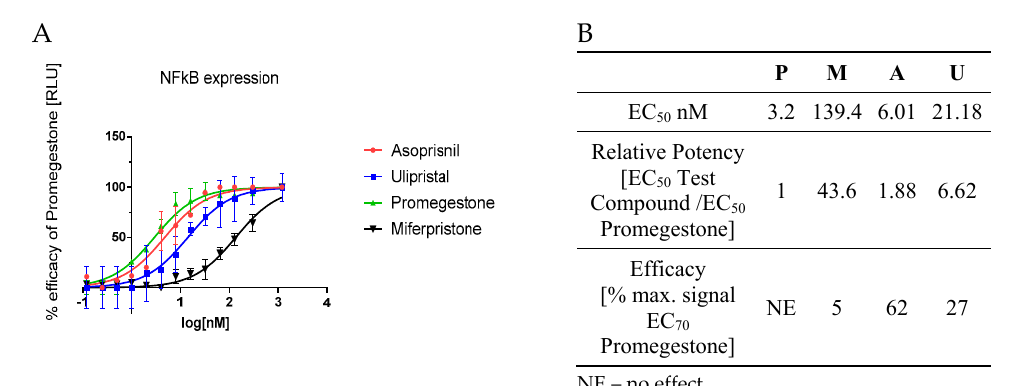
Figure 2. NFkB expression analysis upon SPRM activity in transcription and transactivation manner